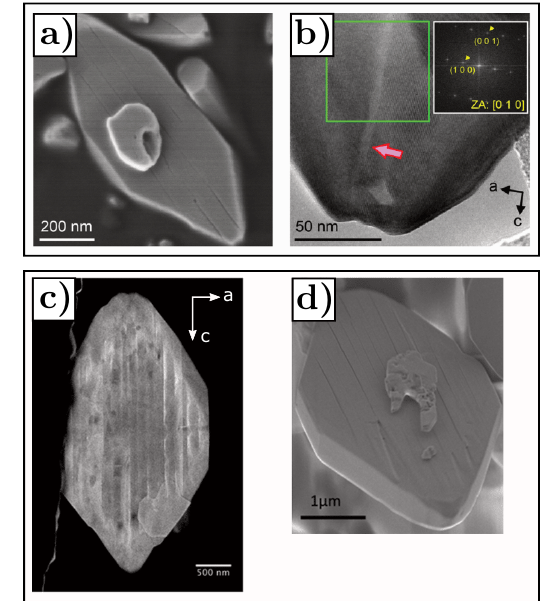
Figure 16. Top: Electron microscopy results for a micrometric plate-like LFP crystal subjected to partial chemical delithiation. ( a ) SEM image and ( b ) High-resolution transmission electron (HRTEM) image with the inset of the Fourier transform pattern obtained from the region marked with the green box. The red arrows indicate the crack running parallel to the c -axis. Reprinted with permission by American Chemical Society from [97], Copyright 2015. Bottom: SEM observations of partially delithiated Li 0.5 PO 4 crystal. ( c ) SEM image and ( d ) STEM-HAADF image, showing cracks evenly spaced and oriented along the c -axis. Reprinted with permission by American Chemical Society from [96], Copyright